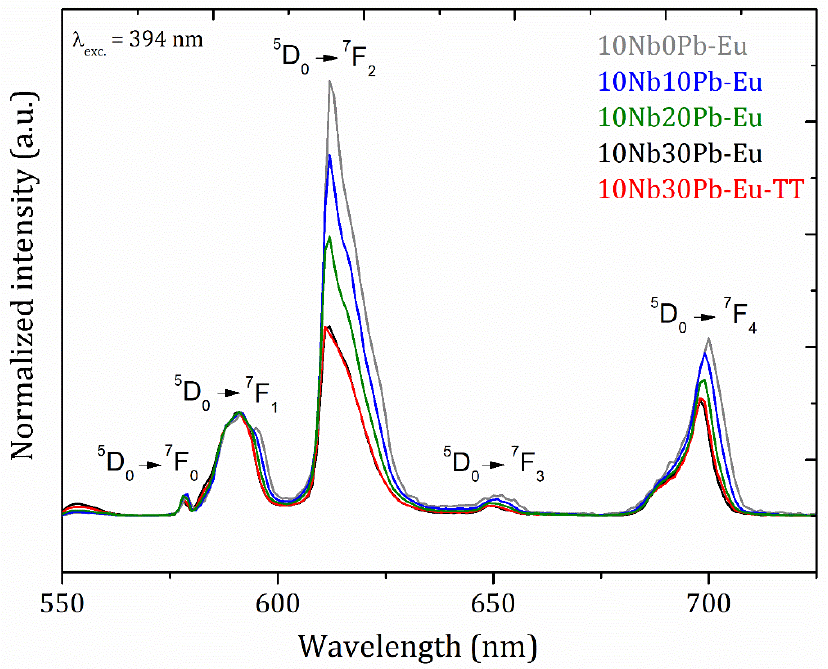
Figure 10. Emission spectra of Eu 3+ -doped glasses and glass-ceramics in the ternary system (90−x)TeO 2 -10Nb 2 O 5 -xPbF 2 under excitation at 394 nm. x)TeO 2 -10Nb 2 O 5 -xPbF 2 under excitation at 394 Table 2. 5 D 0 → 7 F 2 / 5 D 0 → 7 F 1 intensity ratios, experimental lifetime (τ exp , ms) from 5 D 0 → 7 F 2 transi- tion for Eu 3+ ions, total radiative transition probability from level 5 D 0 (A T , s −1 ), radiative lifetime (τ rad , ms), and quantum efficiency (η, %) in Eu 3+ -doped glasses and glass-ceramic.